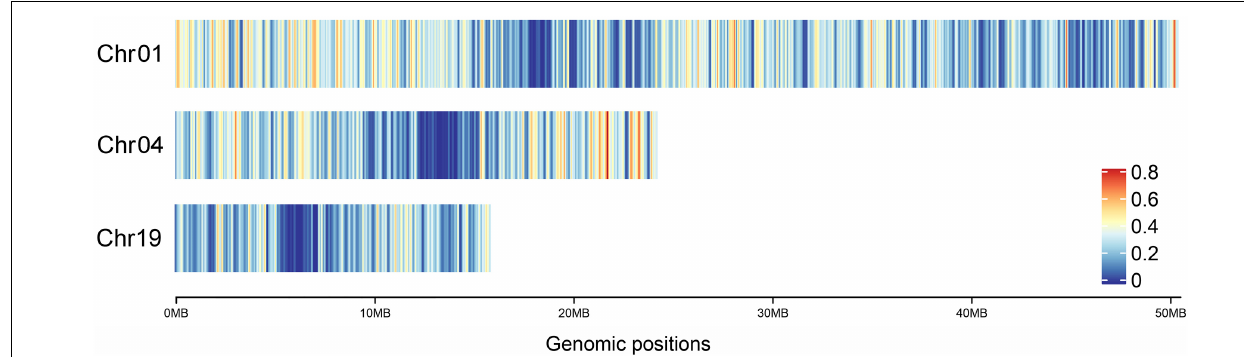
FIGURE 6 | Heat map of gene density on Chr01, 04, and 19 in P. trichocarpa .